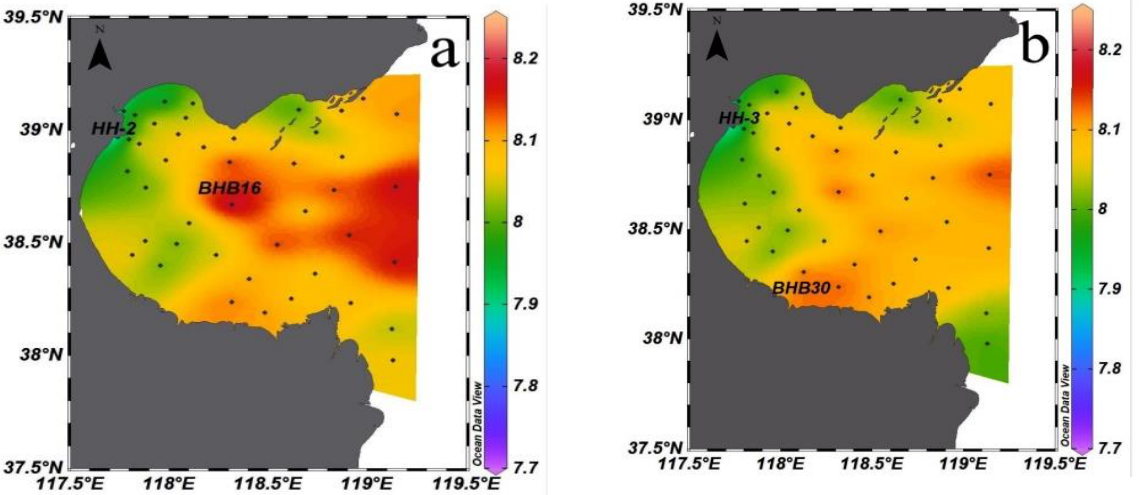
Figure 3. Horizontal distributions of pH in the surface seawater ( a ) and bottom seawater ( b ) in Bohai Bay in summer 2020. The scale is 1:3,700,000. This image was created by ODV software, version 5.3.0(Alfred Wegener Institute, Bremerhaven, Germany).